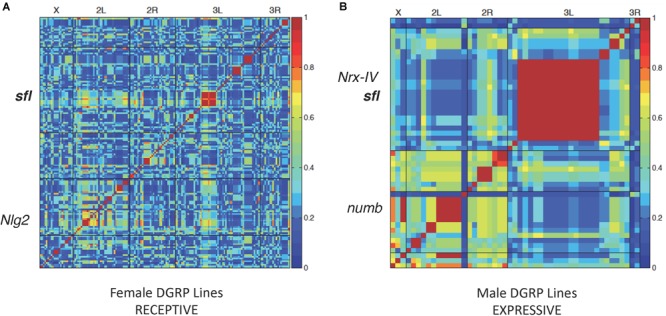
Linkage disequilibrium heatmaps and social communication. LD map of variants associated with female (A) or male (B) DGRP lines in the mating latency test. Each DGRP line was tested three times and the average mating latency used for LD mapping for 40 lines using the online GWAS tool2. Red regions represent significant association between those variants and mating latency. Several variants were in or around known autism associated genes Nlg2, Nrx-IV, and numb. variants in sfl were also associated with mating latency from both the receptive (A) or expressive (B) side of the mating test.